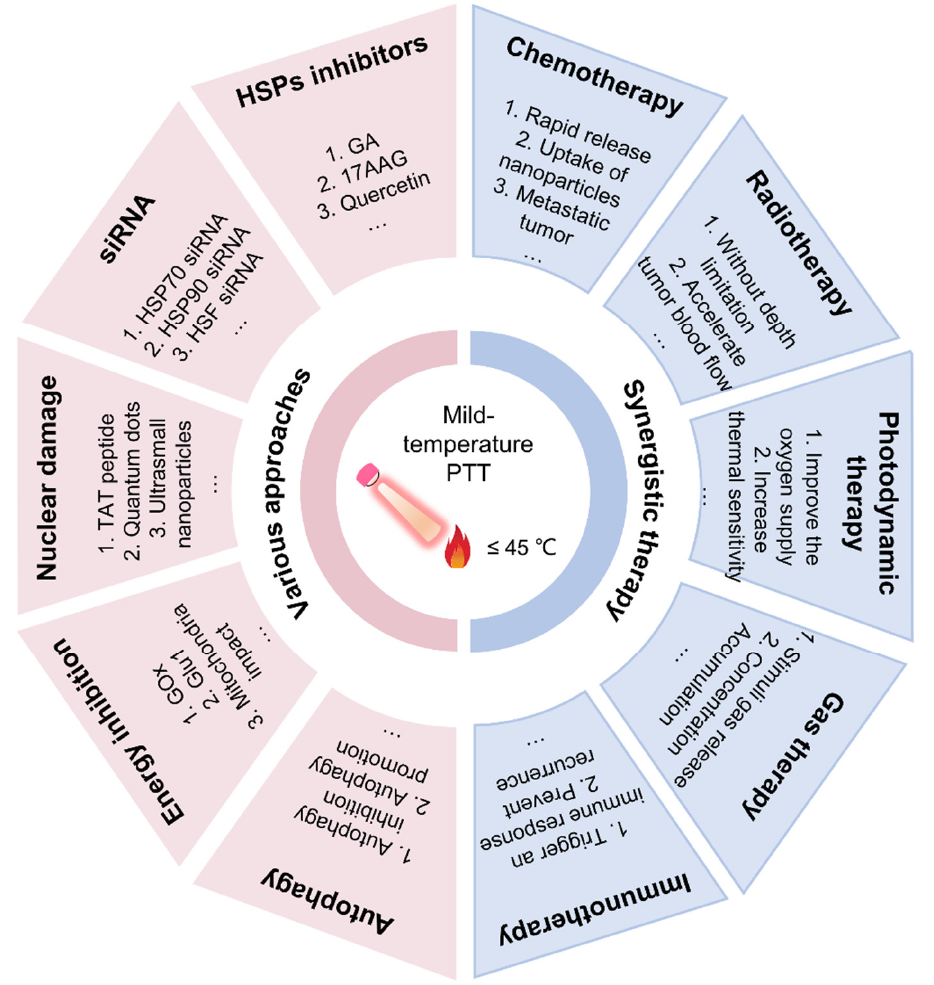
Figure 1. Scheme illustrating the use of MTPTT for cancer treatment via various strategies.